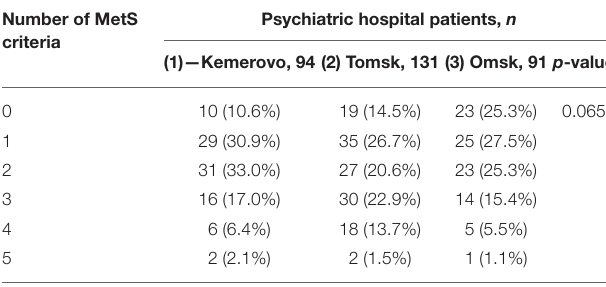
These data were analyzed using the χ 2 test; MetS, metabolic syndrome.